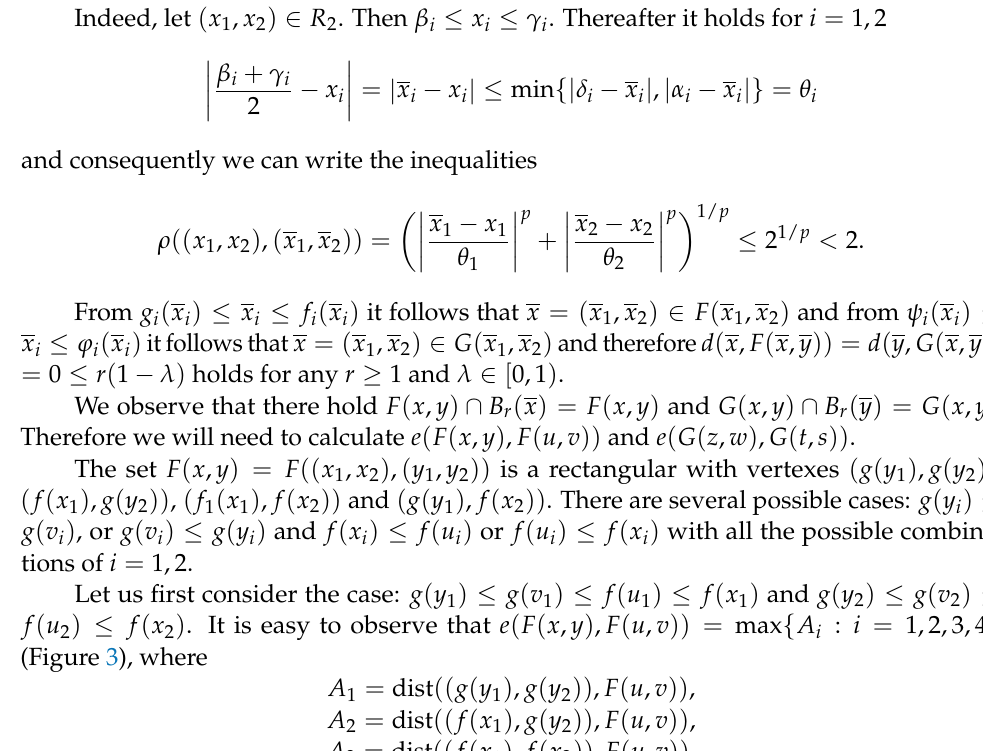
Figure 2. R 2 ⊆ B 2 ( x ) ⊆ R 1